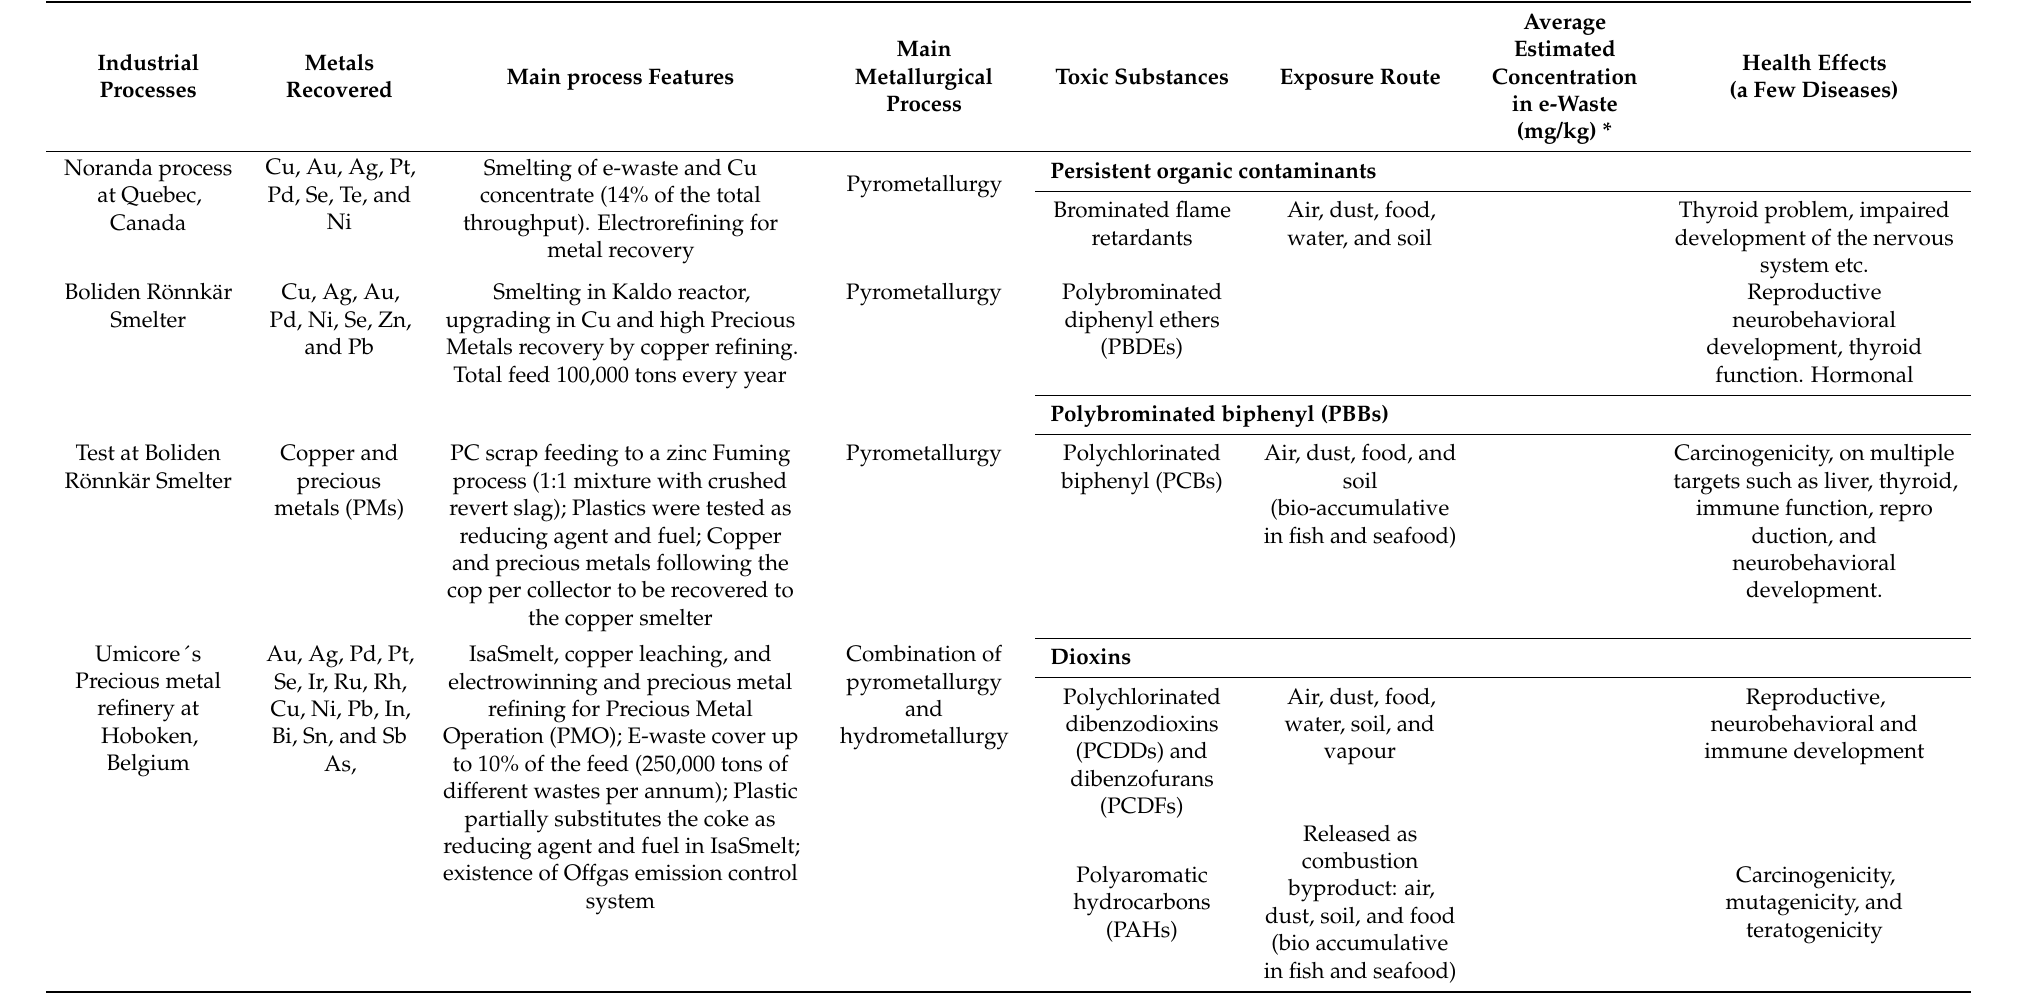
Table 2. Typical hydrometallurgical/pyrometallurgical processes for recovery of valuable metals from e-waste and associated toxic substances